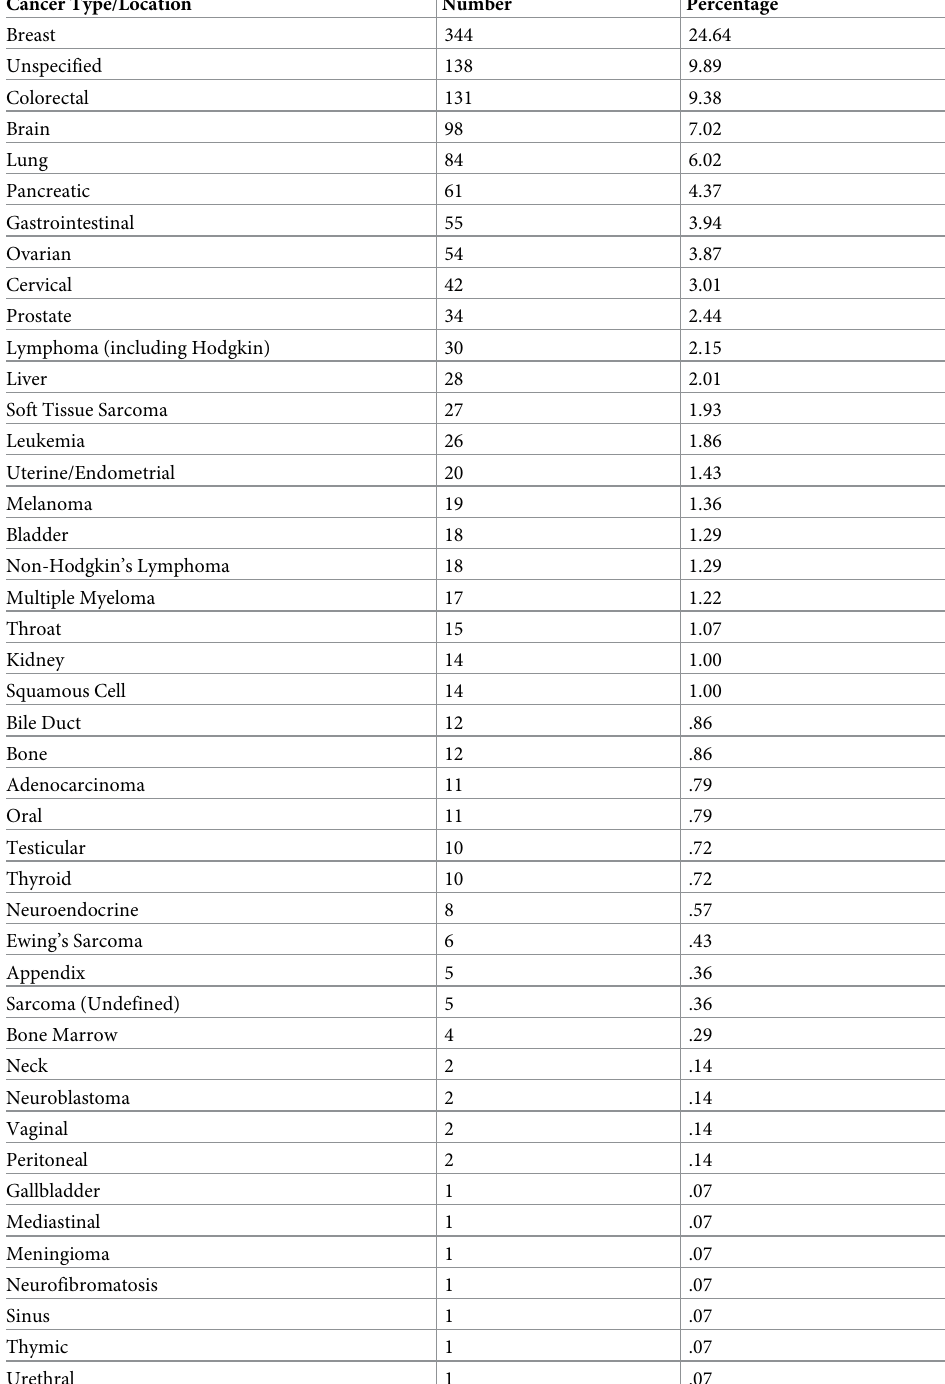
Table 3. Cancer types and